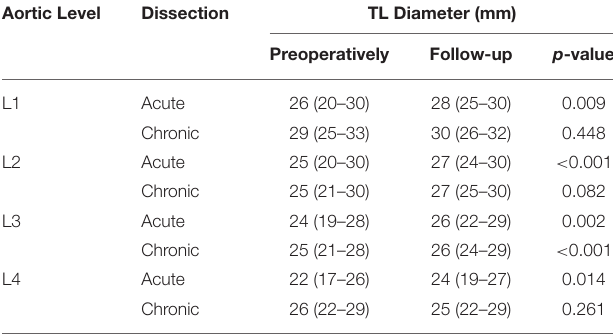
TABLE 3 | Summary of TL diameter results from Iafrancesco et al. (E-Vita) (10). Aortic